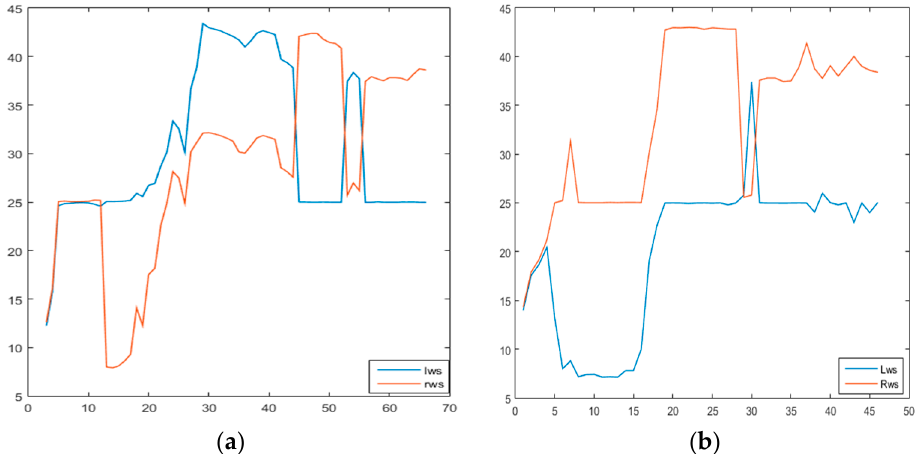
Figure 18. Robot wheel speed for the two scenarios (1. Scenario ( a ), 2. Scenario ( b )) from Figures 14–16.